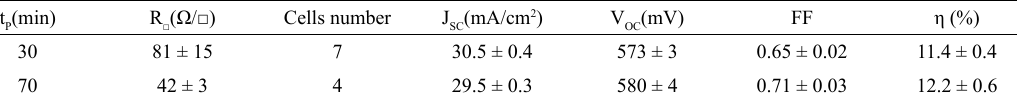
Table 4. Average electrical parameters of the solar cells as a function of the phosphorus diffusion time (t 0.15 %.